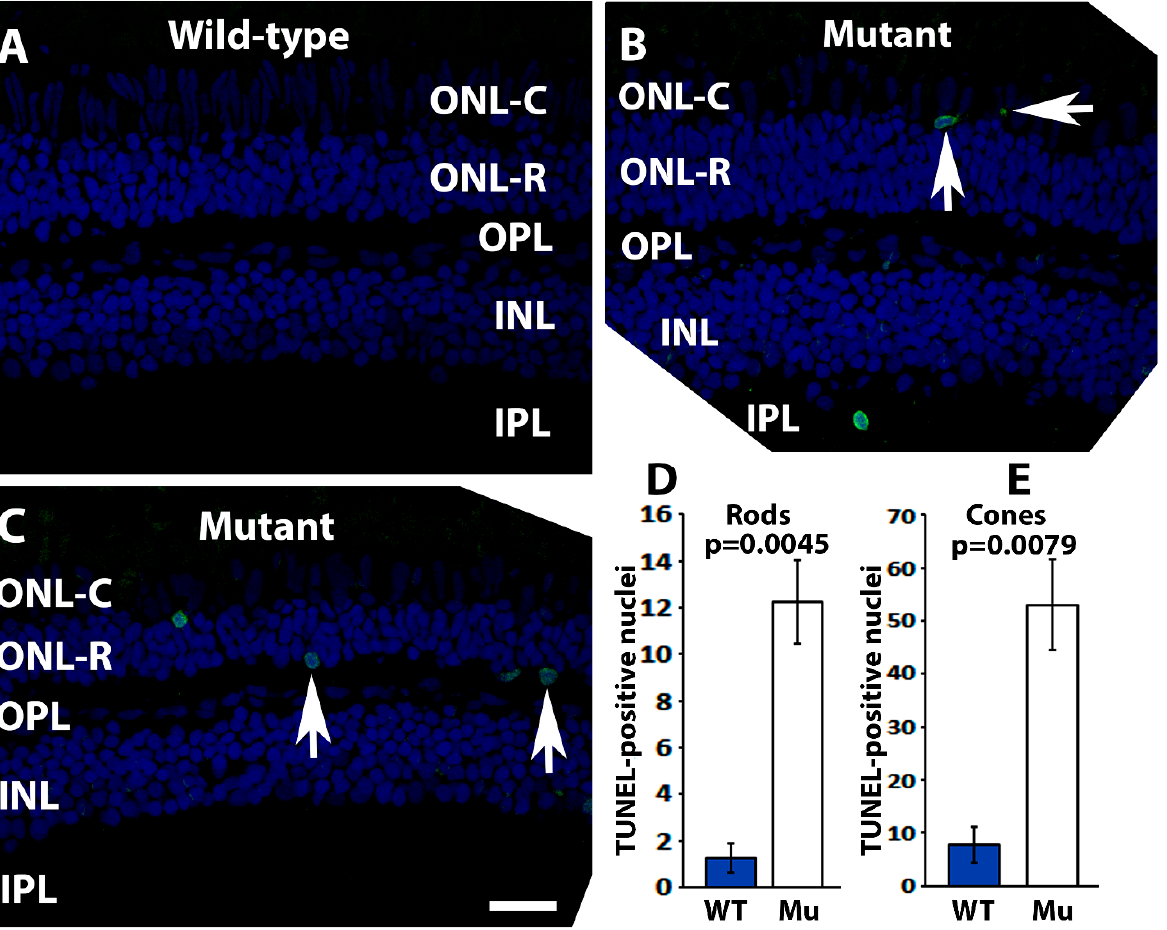
Figure 4. The quantity of TUNEL-positive photoreceptor nuclei was increased in pomt2 mutant retinas. A TUNEL assay was carried out on zebrafish retinal sections at 6-mpf (green fluorescence). The sections were counter-stained with DAPI (blue fluorescence). ( A ) Wild-type retina. ( B ) pomt2 mutant retina. Note examples of TUNEL-positive cone nuclei. ( C ) pomt2 mutant retina. Note examples of TUNEL-positive rod nuclei. ( D ) Quantification of TUNEL-positive rod nuclei ( n = 4). The number of TUNEL-positive rod nuclei was significantly increased in pomt2 mutant retinas compared to the controls. ( E ) Quantification of TUNEL-positive cone nuclei ( n = 4). The number of TUNEL-positive cone nuclei was significantly increased in pomt2 mutant retinas compared to the controls. Scale bar in C: 30 µ